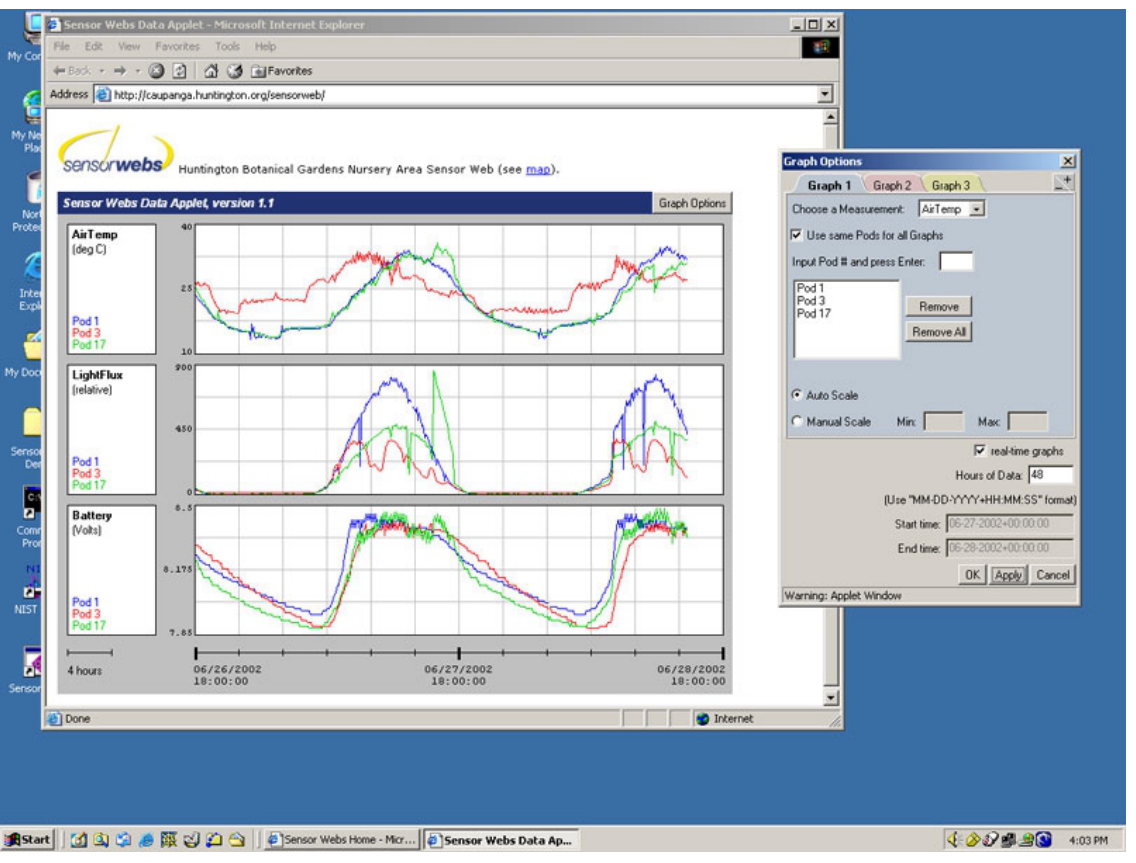
Figure 10. Browser-based GUI for Sensor Web as it appears on the